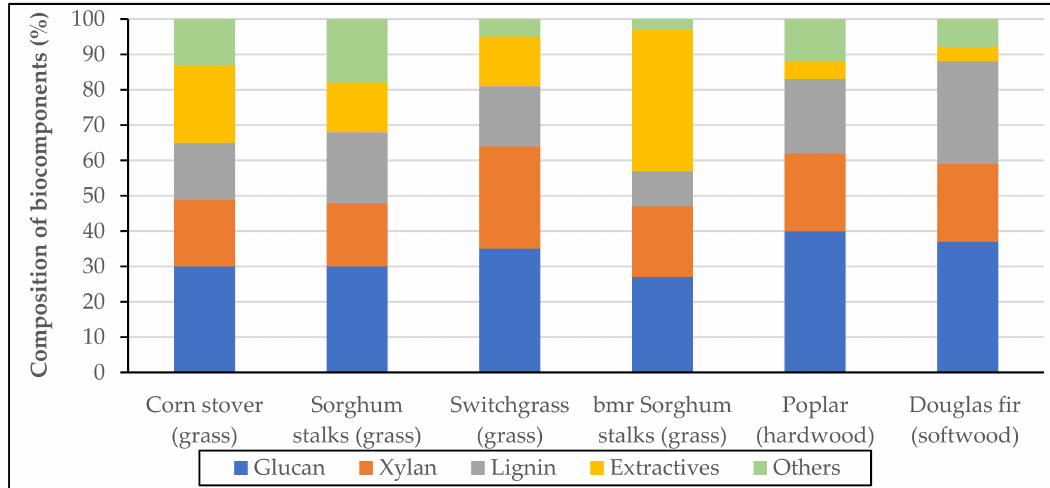
Figure 3. Composition of different biomass feedstocks. Glucan, Xylan, total lignin and total extractives were determined by following the protocols of NREL/TP-510-42618 and NREL/TP-510-42619